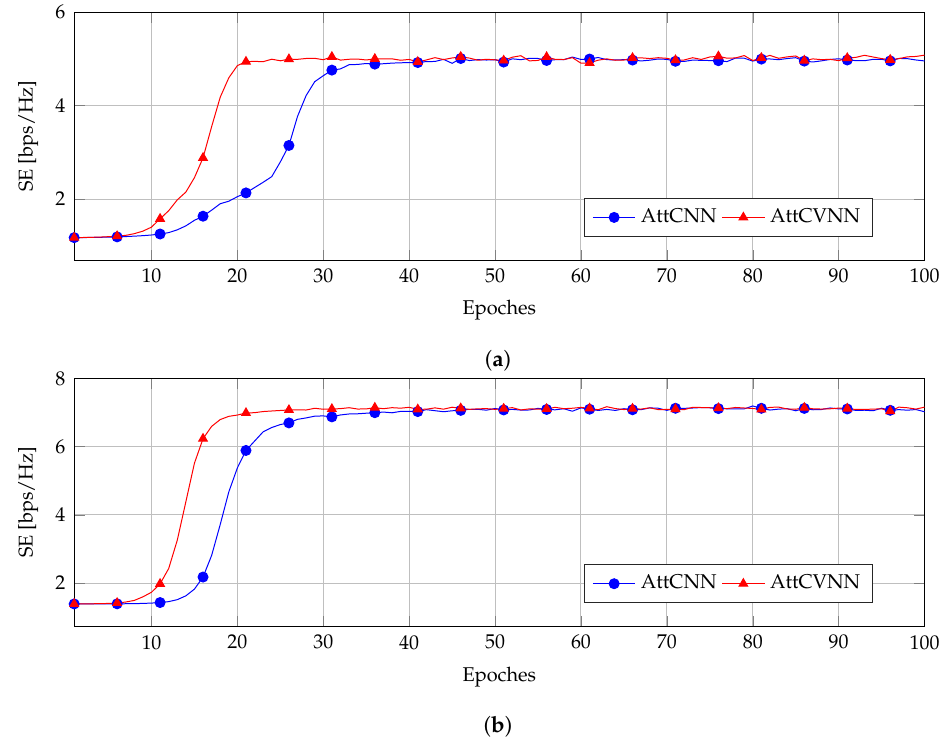
Figure 4. Convergence rate for the configuration INR = 30 dB: ( a ) SNR PB = 60 dB; ( b ) SNR PB = 50